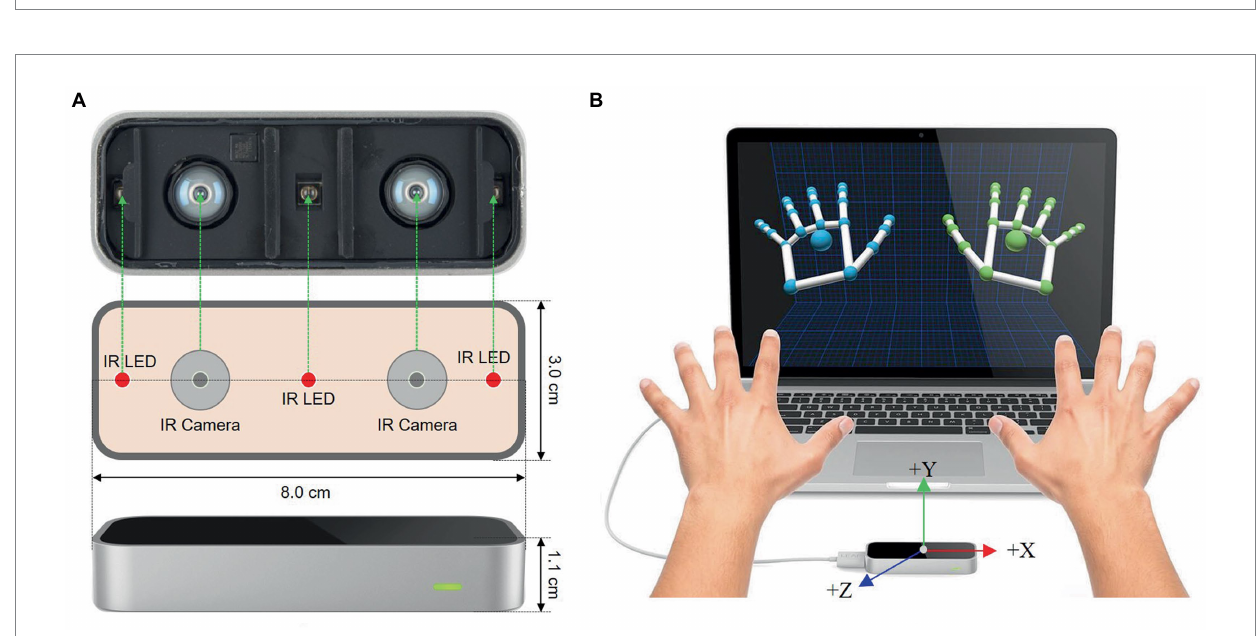
FIGURE 3 The view of Leap Motion Controller (LMC). (A) Schematic view of LMC. (B) 3D view of human hand from LMC (Weichert et al.,